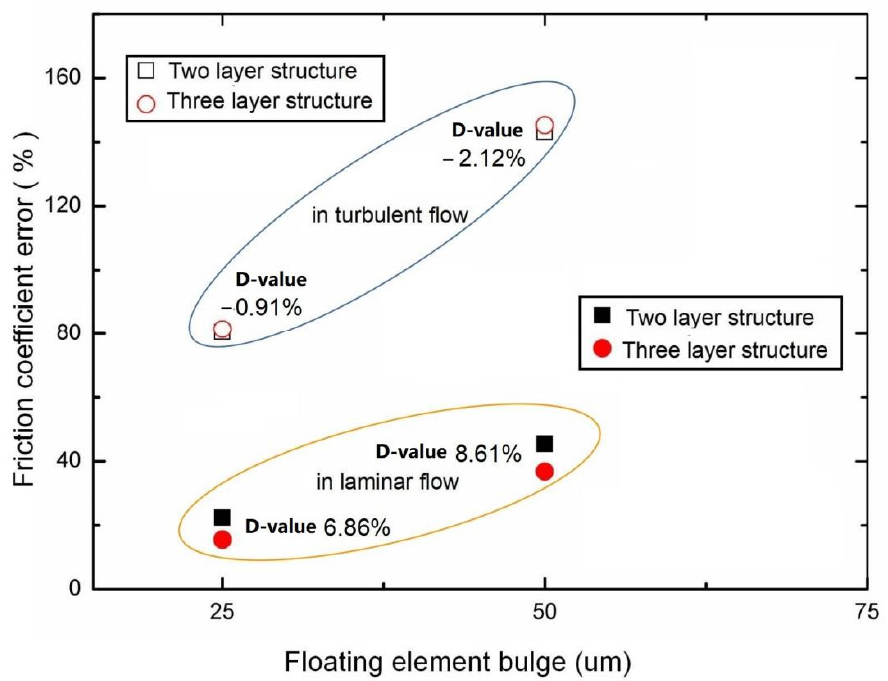
Figure 5. The friction coefficient error of the sensors with a different floating element under different flow fields.